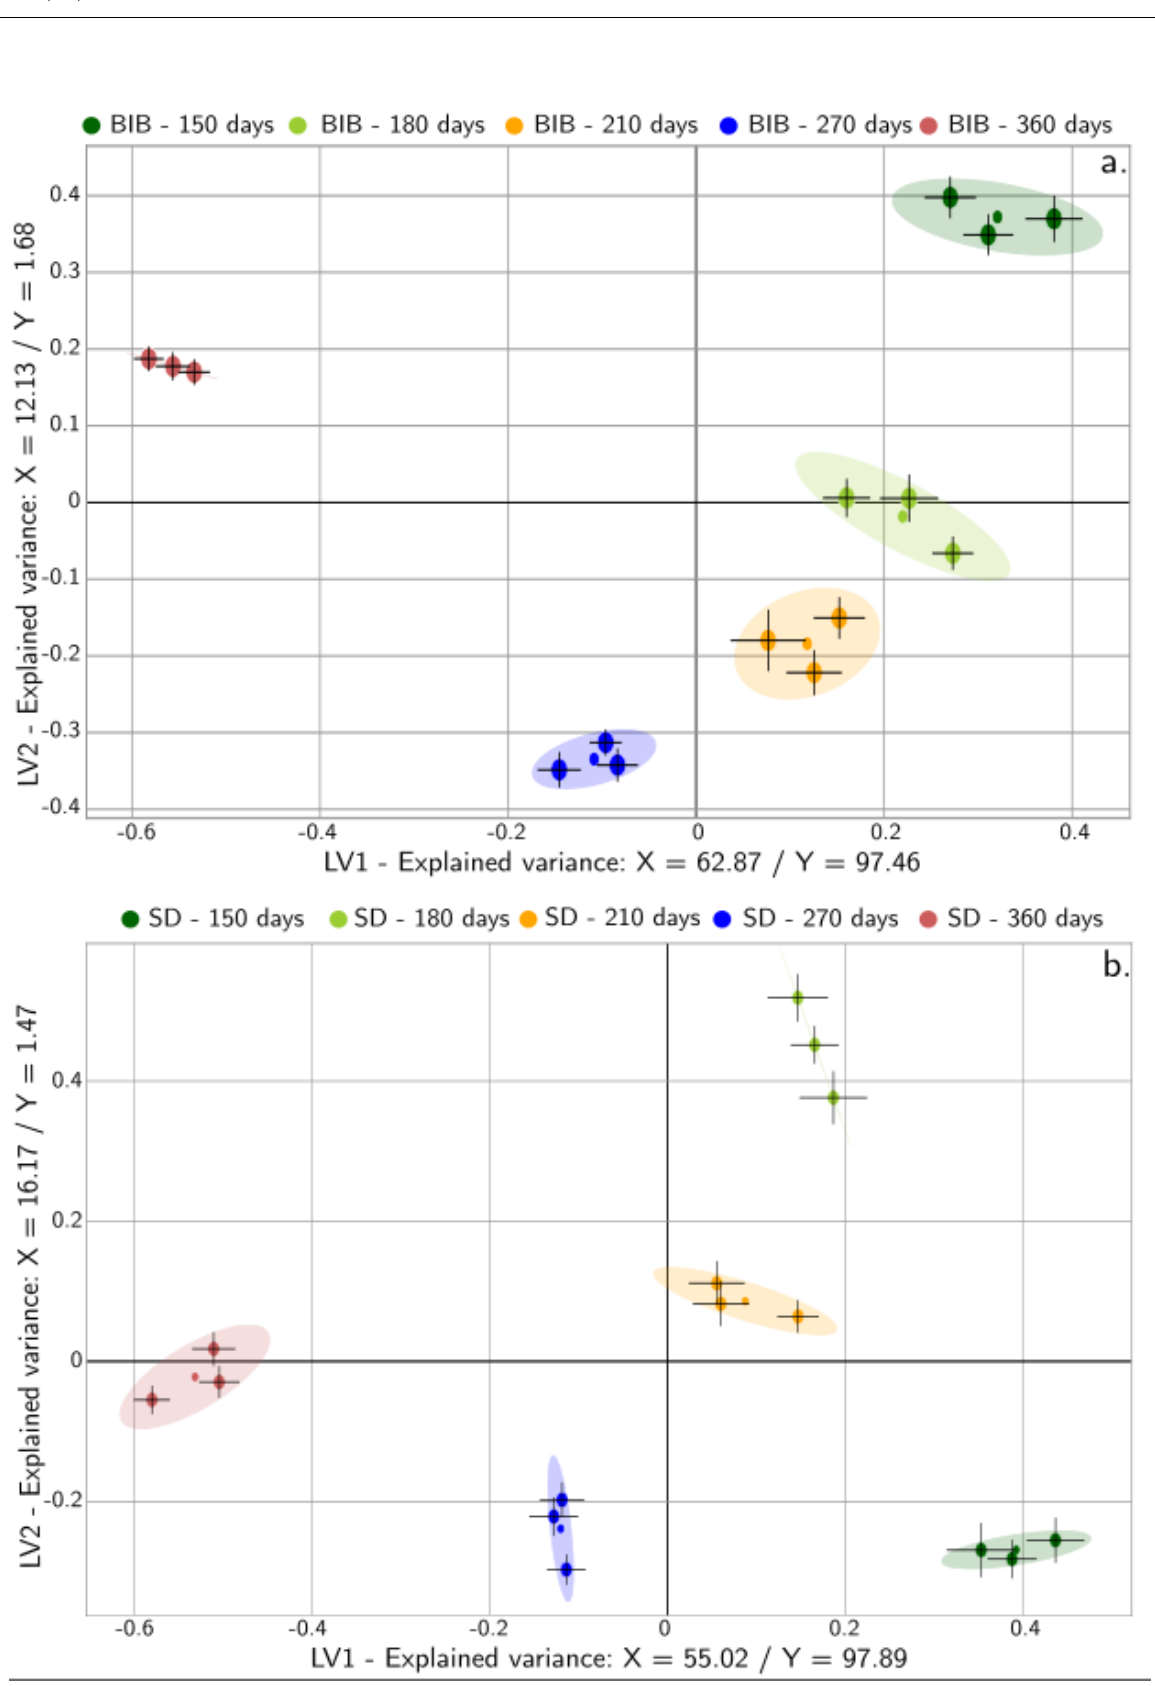
Figure 3. Score plot for the first two latent variables (LV1/LV2) for the acceptability model of the two CLCs: ( a ) BIB and ( b ) SD for the multivariate feature - acceptability model. Table 3. Performance statistics for the Partial Least Square (PLS) based acceptability model for both training and test datasets - R 2 and Root Mean Squared Error (RMSE).